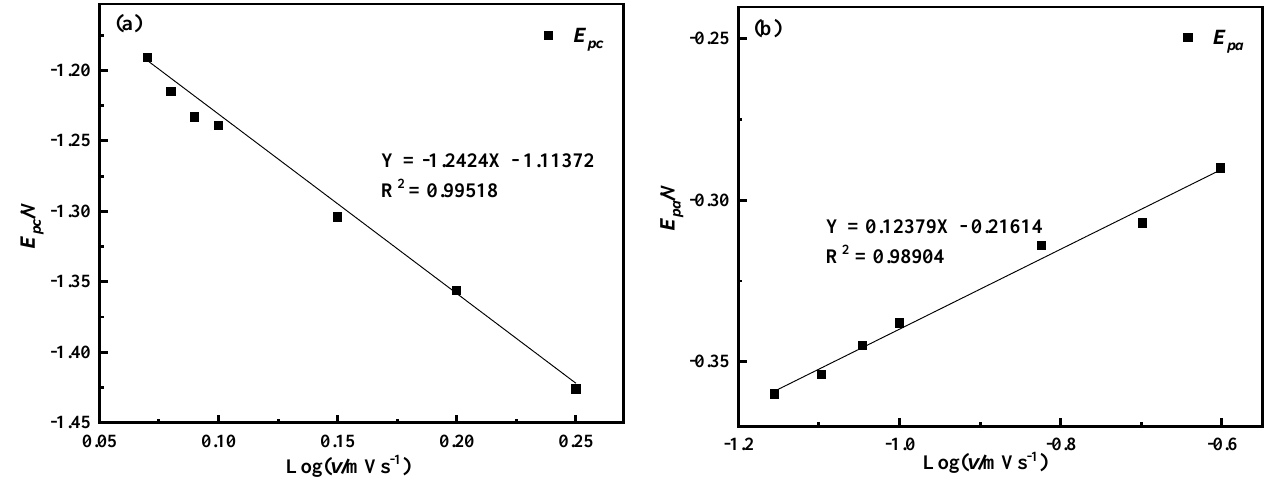
Figure 11. The log v - E pc and log v - E pa curves of peak B (A = 0.32 cm 2 ) ( a ) log v - E pc ( b ) log v - E pa .